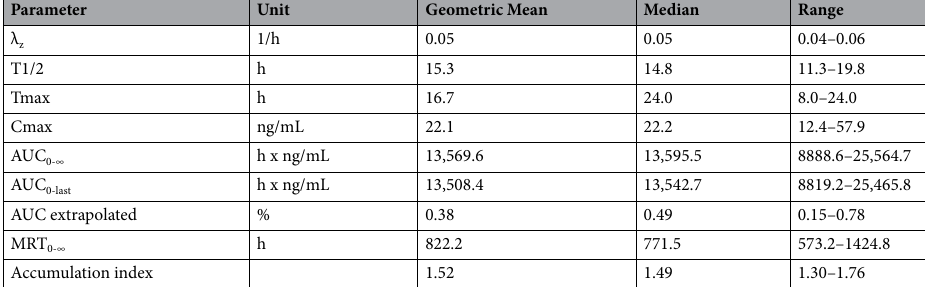
Table 2. Pharmacokinetic parameters of cannabidiolic acid (CBDA) following feeding industrial hemp for 14 days at a target dose of 5.5 mg/kg (n = 8). Note: λ z , first order rate constant associated with the terminal (log-linear) portion of the kinetic curve; T1/2, terminal half-life; Tmax, the time of maximum observed concentration during the first dosing interval; Cmax, the maximum observed concentration at the first Tmax during the first dosing interval; AUC 0-∞ , area under the concentration curve (AUC) from the dosing time extrapolated to infinity based on the last observed concentration; AUC 0-last , AUC from the time of dosing to the last measurable concentration; AUC extrapolated, percentage of AUC 0-∞ due to extrapolation from Tlast to infinity, MRT 0-∞, mean residence time extrapolated to infinity; Accumulation index, the ratio of accumulation of a drug under the steady state condition after repeated administration as compared to a single dose.